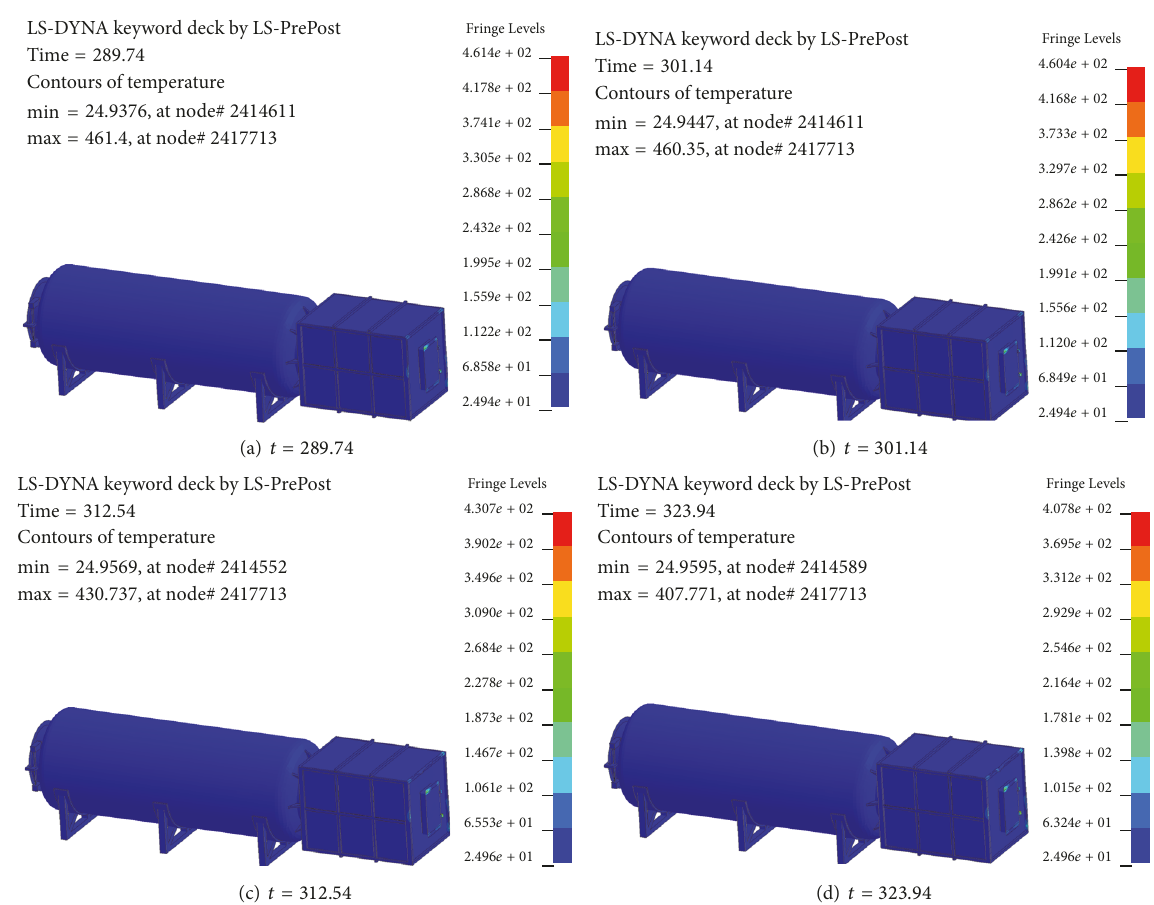
Figure 12: Displacement change for the rescue